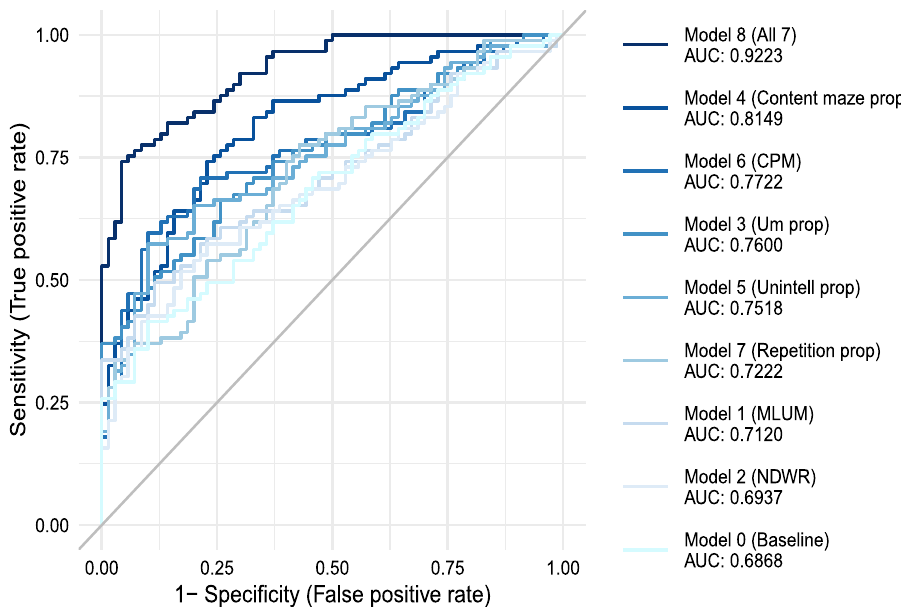
Figure 2. ROC curve for logistic regression models, evaluated on class probabilities. AUC is area under the curve. Baseline is modeled with only IQ and age as independent variables. All other models are adjusted on IQ and